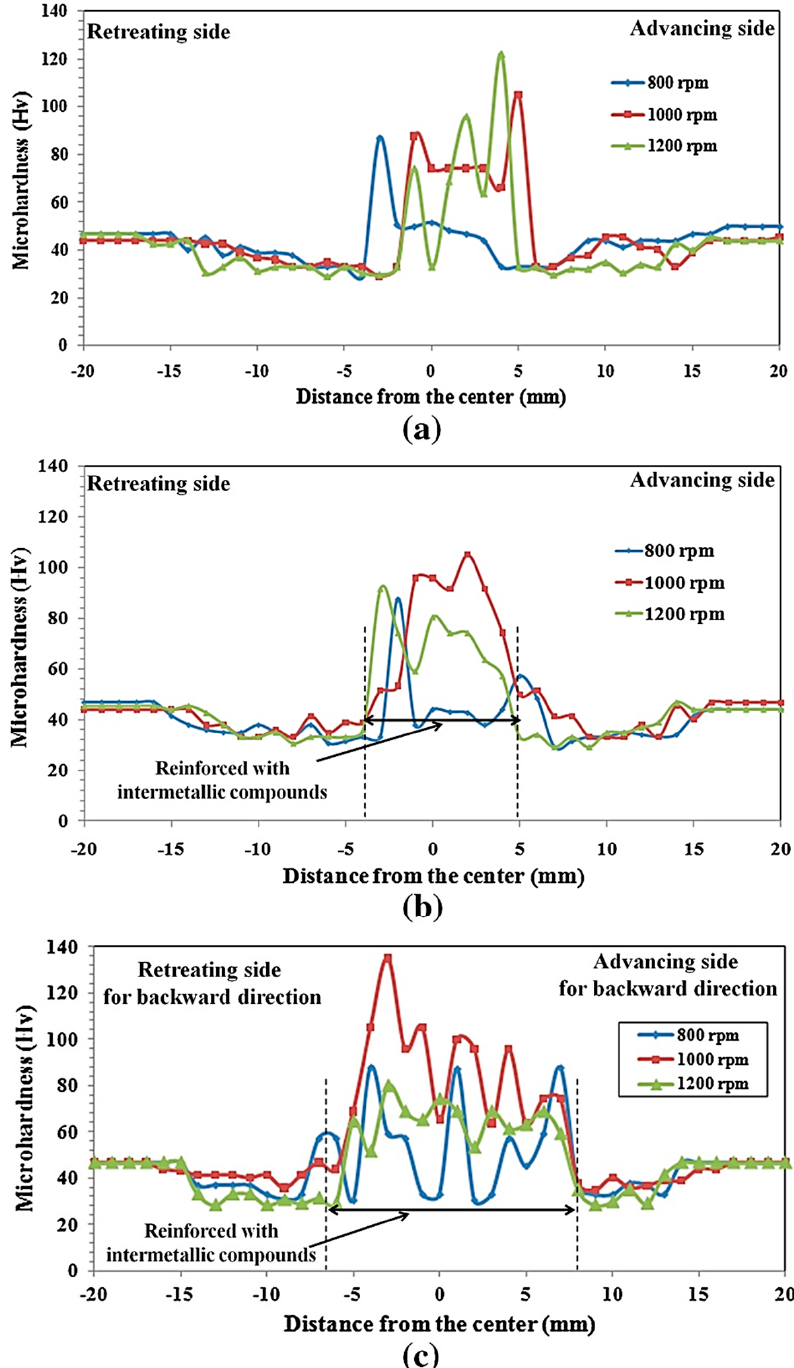
Figure 16. Hardness distribution in cross-section after ( a ) F pass (one pass), ( b ) 2F passes (the second pass is the first pass direction), ( c ) FB passes (the second pass is in the reverse direction of the first pass), at a travel speed of 100 mm/min [56]. Reprinted from: The effect of Cu powder during friction stir welding on microstructure and mechanical properties of AA3003-H18. Metallurgical and Materials Transactions A 45 (2014): 3882–3891, Abnar, B., M. Kazeminezhad, and A. H. Kokabi, Copyright 2014, with permission from Springer